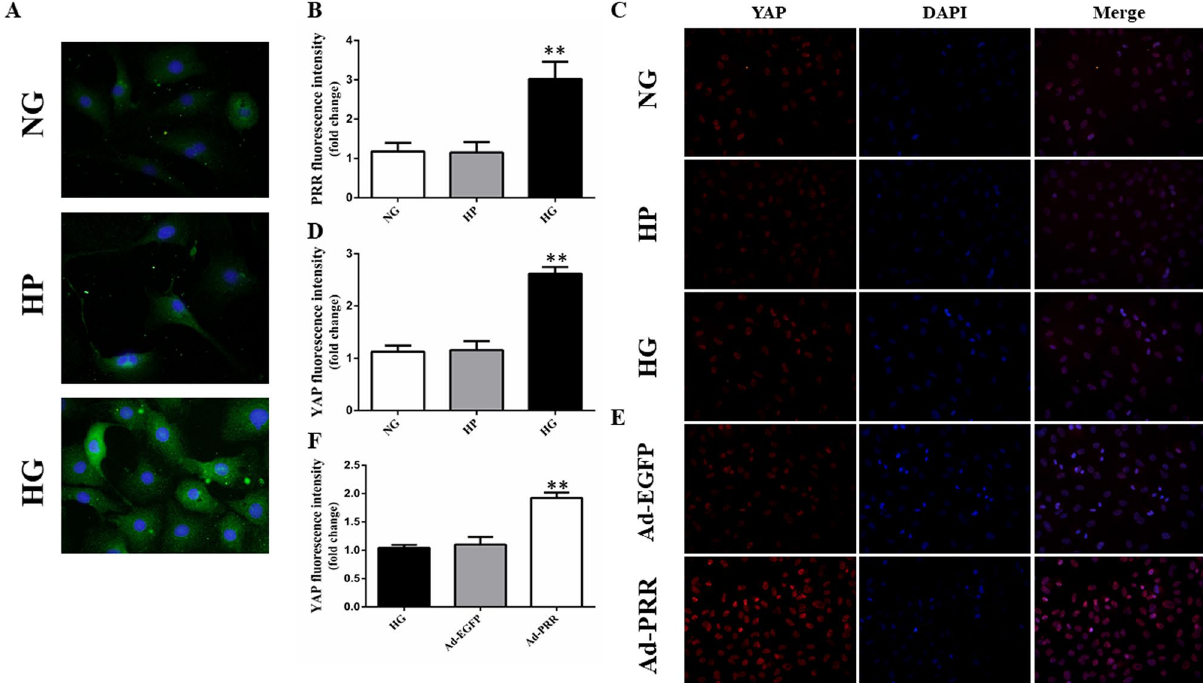
Figure 3. (Pro)renin receptor and YAP expression in cardiac fibroblasts. ( A ) Immunofluorescence showing PRR protein expression in the cardiac fibroblasts (CFs) in the control group, high permeability group and high glucose group. ( B ) Quantitative analysis of the results shown in ( A ). ( C ) Immunofluorescence showing YAP protein expression in the cardiac fibroblasts (CFs) in the control group, high permeability group and high glucose group. ( D ) Quantitative analysis of the results shown in ( C ). ( E ) Immunofluorescence showing YAP protein expression in the cardiac fibroblasts (CFs) in the high glucose group, Ad-EGFP group, and Ad-PRR group. ( F ) Quantitative analysis of the results shown in ( E ). ** p < 0.01 compared with the control group and high permeability group. ## p < 0.01 compared with the high glucose group and Ad-EGFP